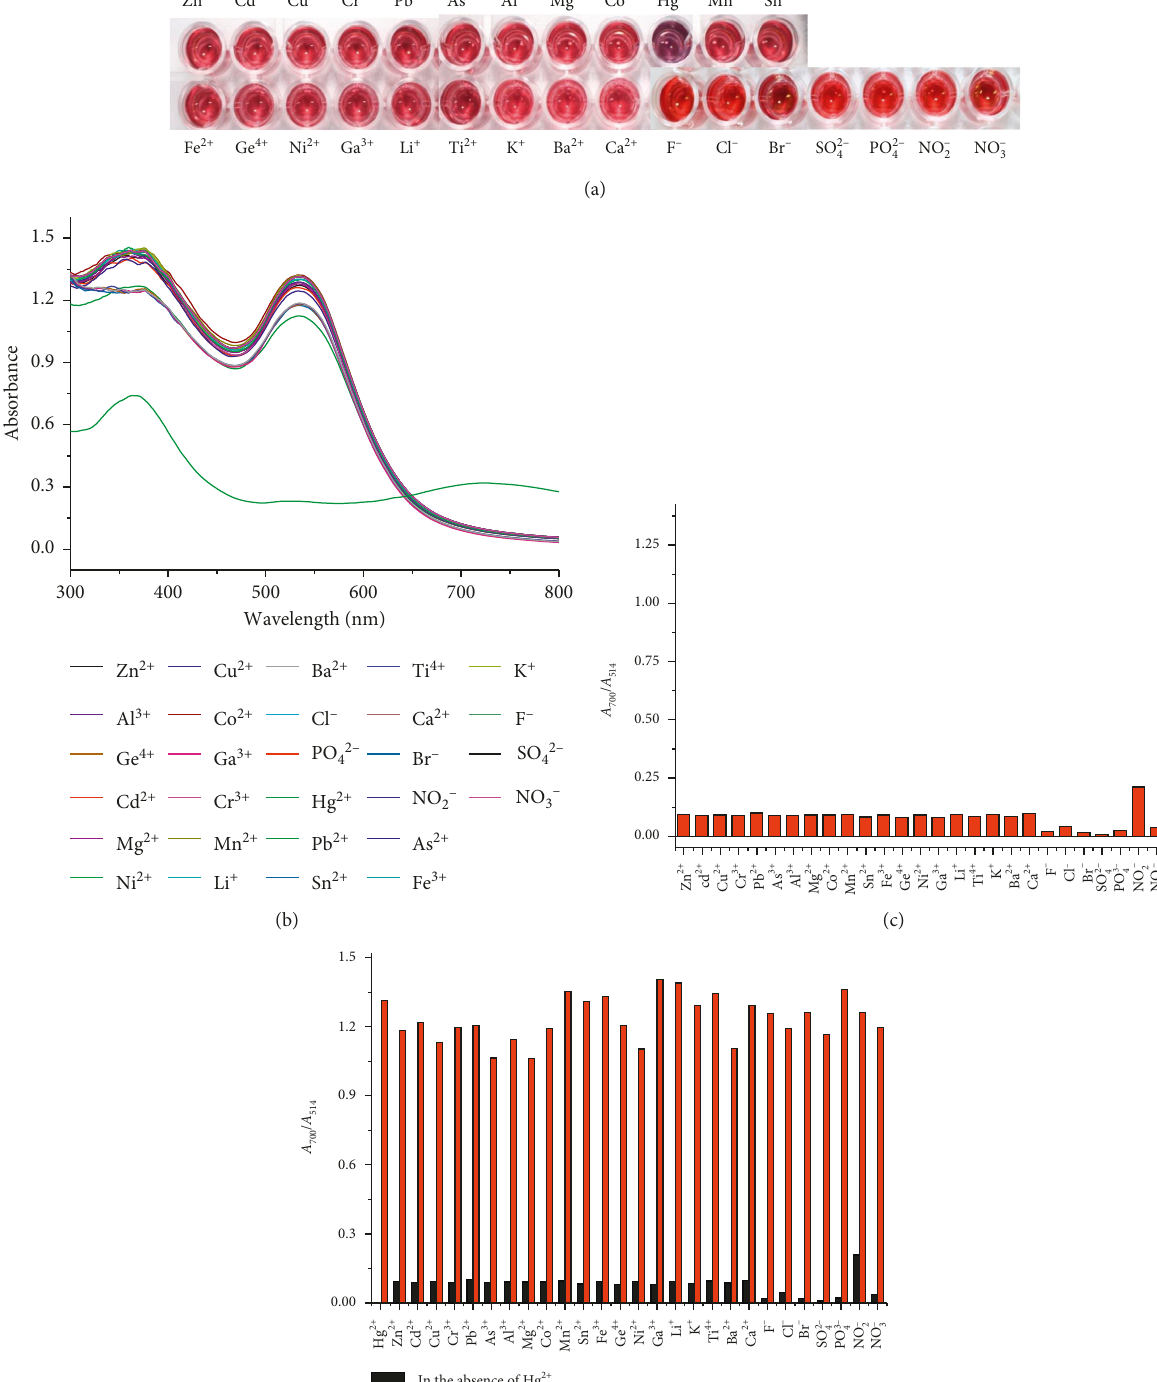
Figure 2: (a) Photographic images, (b) UV-Vis absorption spectra, (c) absorption ratios ( A and 50 μ M various ions at pH 7, 50 ° C, and 500mM various ions in the presence and absence of 5.0 μ M